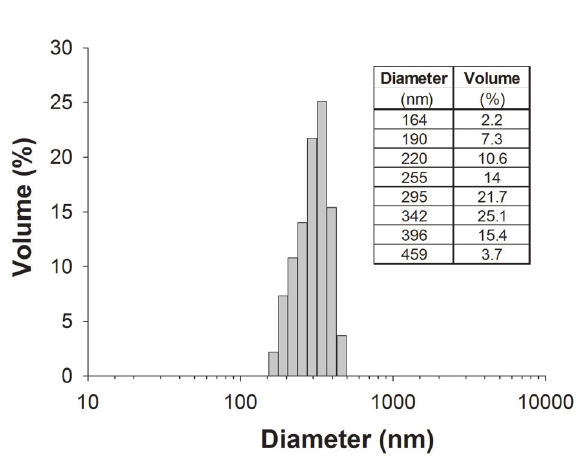
Figure 2: Particle size of magnesium hydroxide precipitated by 10% magnesium nitrate at 40°C.